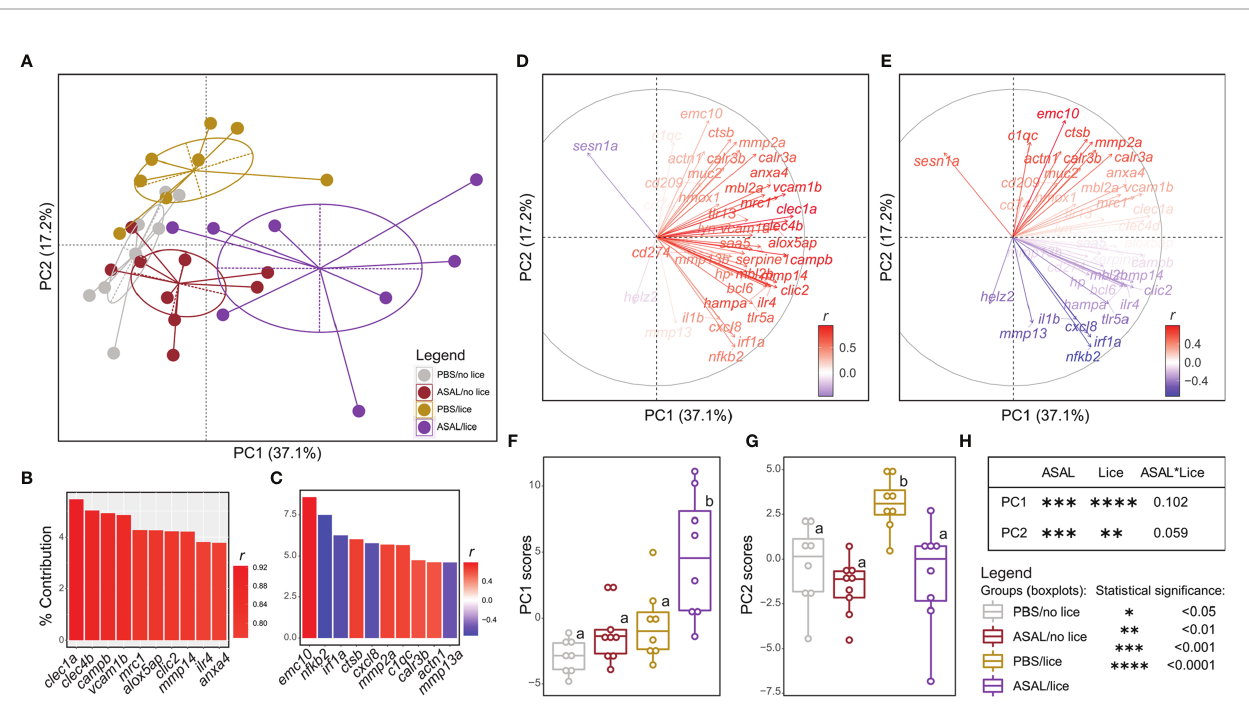
FIGURE 9 | Principal component analysis (PCA) of the microarray validation qPCR data. (A) PCA plot illustrating the distribution of all salmon included in the qPCR validation experiment (n = 33) in the multivariate space. The dots on the plot represent salmon and are colored based on the injection/infection group to which they belong. (B, C) Bar plot representing the top 10 GOIs contributing (%) to the PC1 and PC2 variances, respectively. Each GOI ’ s bar is colored based on their correlation with the variance explained by PC1 (B) and PC2 (C) . (D, E) Loading vector plot showing the association of each GOI with the variance explained by PC1 and PC2. Vectors are colored based on their correlation with PC1 ’ s (D) and PC2 ’ s (E) variances. (F, G) Scatter plot/boxplot overlays representing individual/group PC1 and PC2 score data, respectively. Lowercase letters indicate signi fi cant differences between groups, as determined by estimated marginal means. (H) Summary of the results from the generalized linear model (GLM) analysis of the PC1 and PC2 score data. The signi fi cance threshold was p < 0.05 for all statistical